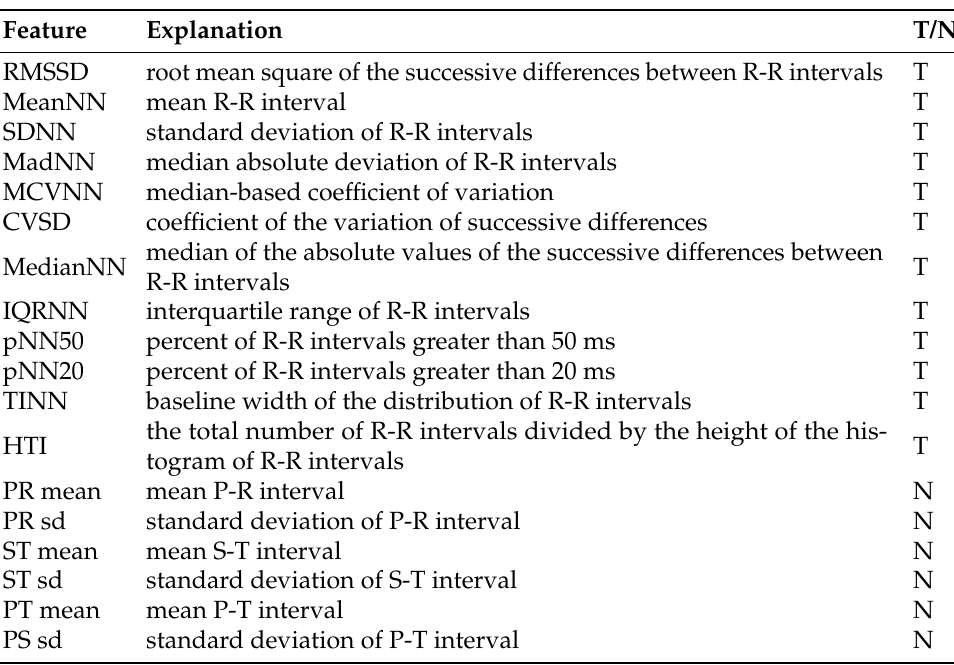
Table 1. List of heart rate variability (HRV) features and their meaning. The right column states whether they are traditional (T) or novel (N)